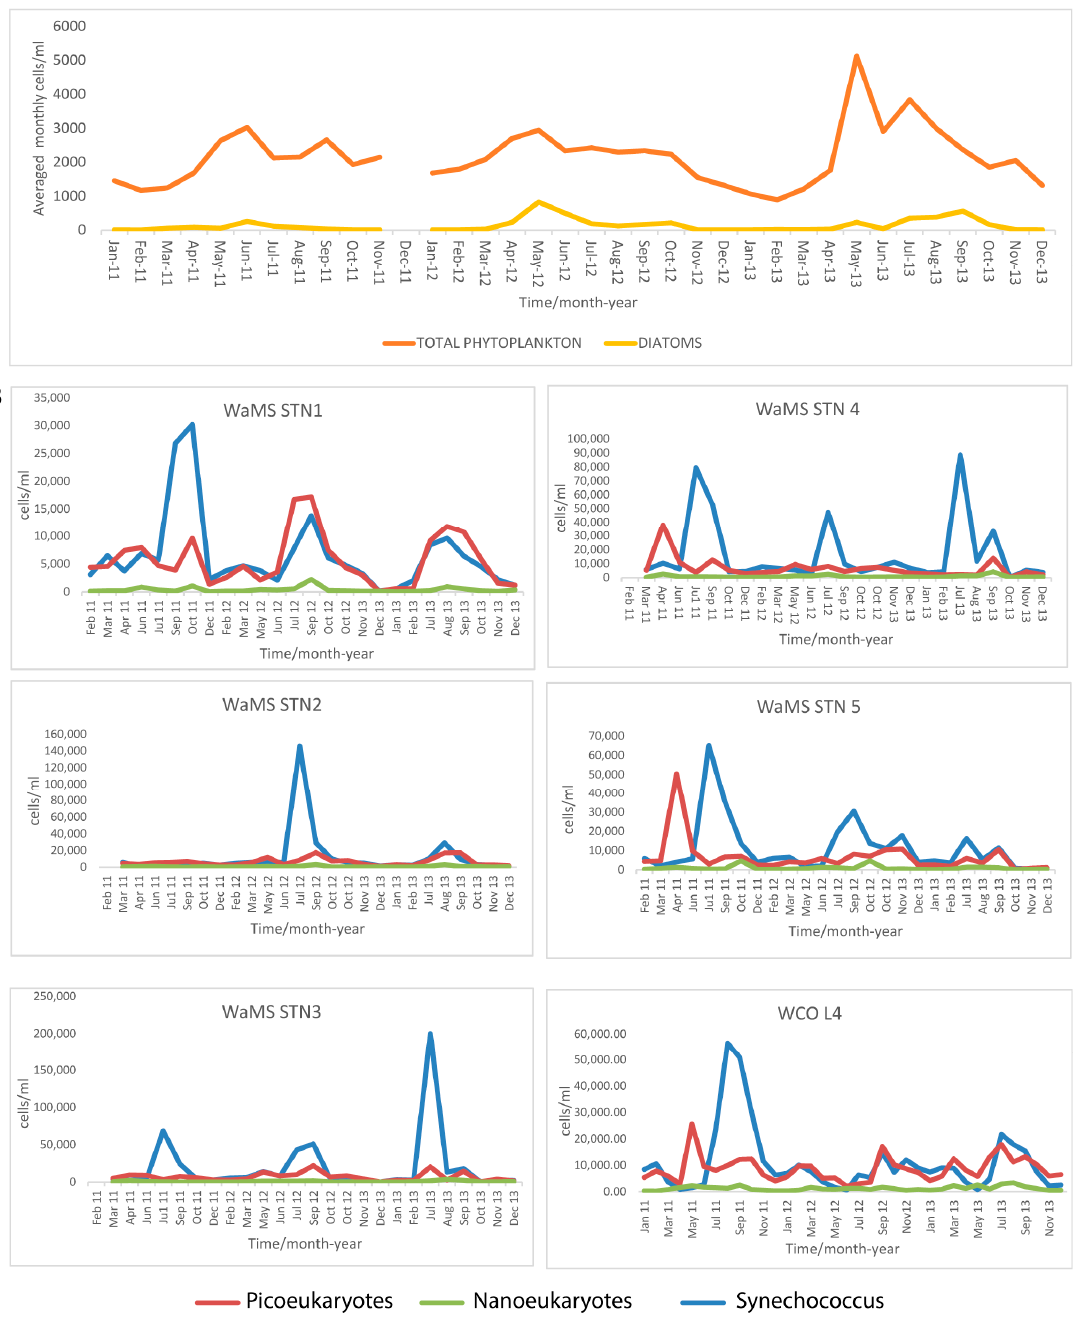
Figure 4. Monthly averaged seasonal cell concentration of Phytoplankton and all diatom microscopic cell counts (cells/mL) from WCO L4 ( A ) versus monthly FC-measured cell concentration aggregated phytoplankton groups of Nanoeukaryotes (2–10 µm), Picoeukaryotes ( ≤ 2 µm) and Synechococcus photosynthetic bacteria from the WaMS 2011–2013 (cells/mL) stations 1–5 compared to same FC-measured groups for WCO L4 station (averaged monthly values) ( B ).